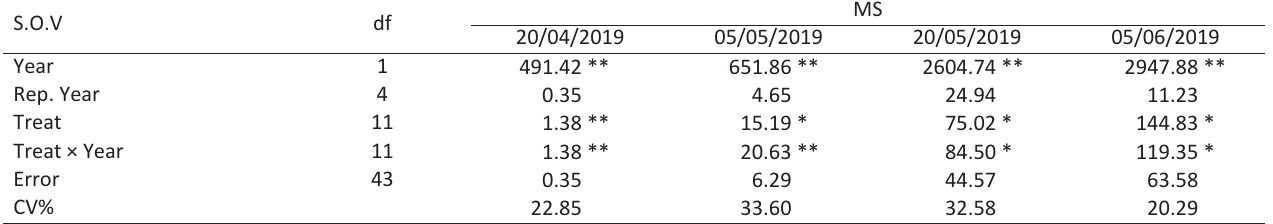
years*, **, NS= significant at 5%, 1% and not significant probability levels, respectively. Table 6 ­ Mean comparison of morphological traits in some Iranian garlic at two